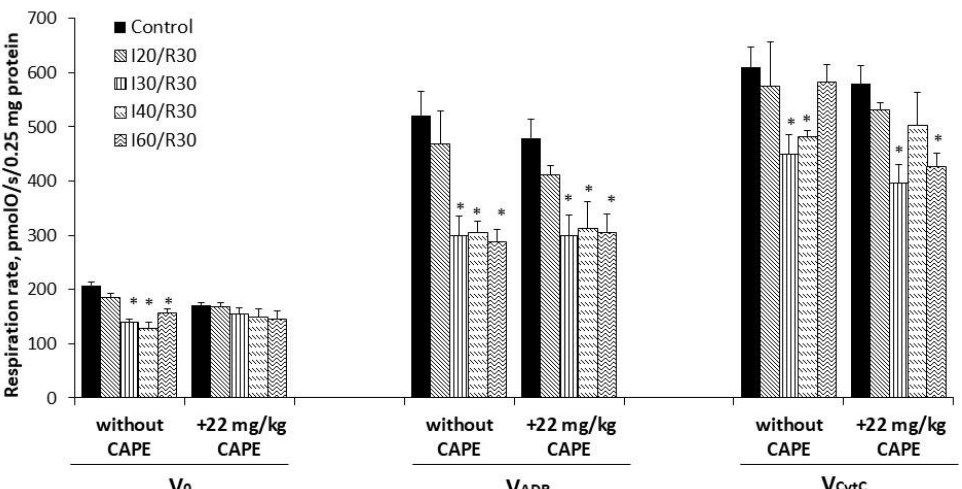
Figure 5. Effect of ischemia/reperfusion and CAPE on the kidney mitochondrial routine and state 3 respiration rate with succinate as a substrate. Mitochondrial respiration rate was measured, as described in the Materials and Methods section, using 15 mM succinate (+50 nM rotenone) as a substrate. V 0 —routine respiration rate in the presence of 0.25 mg/mL of mitochondria and substrate; V ADP —state 3 respiration rate in the presence of 1 mM ADP; V CytC —state 3 respiration rate in the presence of 32 µ M cytochrome c, * p < 0.05 vs. the respective control. One-way ANOVA followed by a Fisher’s LSD post hoc test were used to compare the effects.